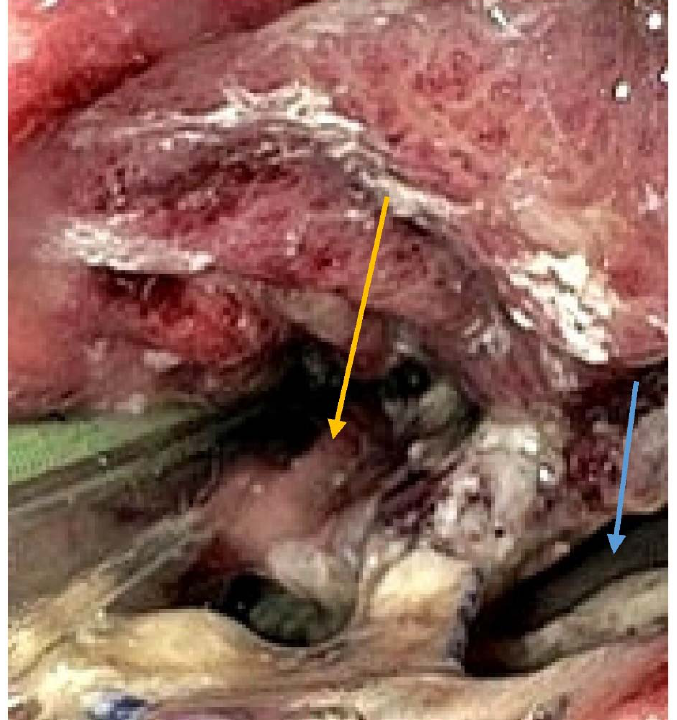
Figure 2. Endoscopy showing a circumferential anastomotic leakage after oesophagectomy indicated by the blue arrow. Yellow arrow is pointing to the true lumen. The radiologist and the endoscopist were blinded to their respective findings.